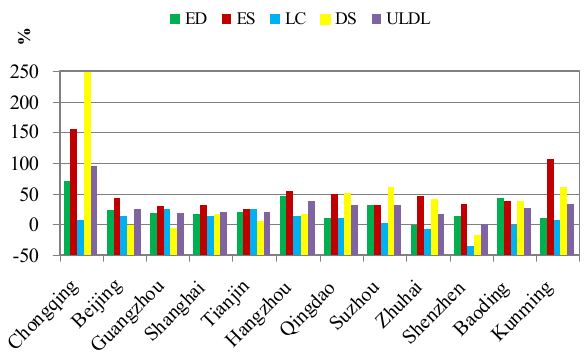
Figure 3. Development speed of the urban low-carbon development level for 12 cities and usage efficiency; LC, Living consumption; and DS, Development